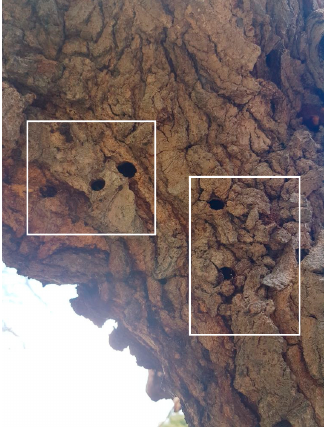
Figure 6. A suspicious tree-trunk: Exit tunnels of adult X. chinensis in a mulberry tree marked with a white rectangle . Although the pests have left the tree through the tunnels they have dug, it is mostly probable that there is another generation of larvae breeding that will lead to the next generation of adult insects.